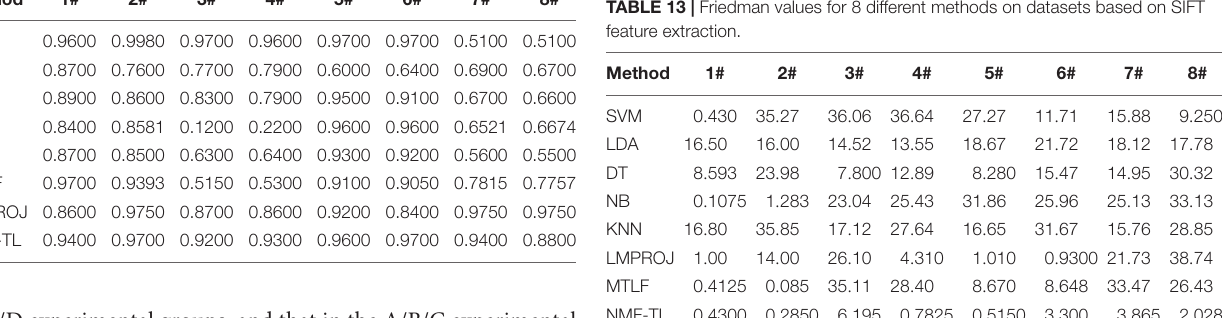
proposed method in the A/B/C and A/B/D groups increased by about 22%; compared with the two transfer learning methods, the recall rate of our method in the A/C and B/C experimental groups increased by about 4%, and the recall rate in the A/D, B/D, and A/B/C experimental groups increased by about